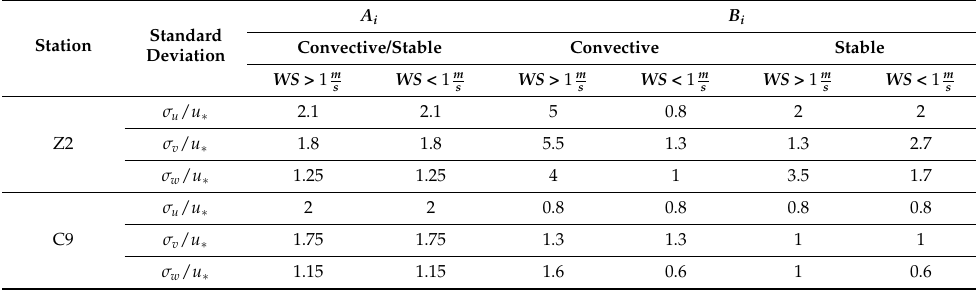
Figure 7. The dimensionless turbulence parameters for σ w / u ∗ , the vertical standard deviation of the wind velocity fluctuations, plotted as functions of z / L both for weak wind ( U ≤ 1 m ; lower part for each station) and for strong wind ( U > 1 m/s; upper part for each station); The Zevulun valley region, as represented by the Z2 (Kiryat Motzkin) weather station is shown in ( a ), while the Mount Carmel region, as represented by the C9 (Tel Hai elementary school, Haifa) weather station is shown in ( b ). Table 2. The standard deviations of wind-velocity fluctuations in the Zevulun valley region, as represented by the Z2 (Kiryat Motzkin) weather station and the ridge of Mount Carmel, as represented by the C9 (Tel Hai elementary school, Haifa) weather